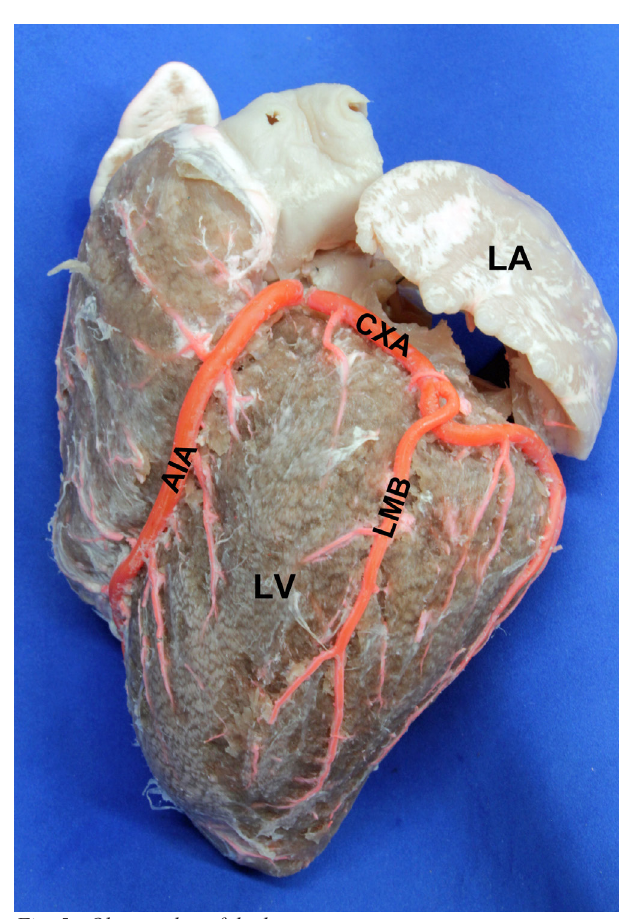
Fig. 5 - Obtuse edge of the heart. LA: Left Atrium. LV: Left Ventricle. AIA: Anterior Interventricular Artery. CXA: Circumflex Artery. LMB: Left Marginal Branch, ending at the apex of the